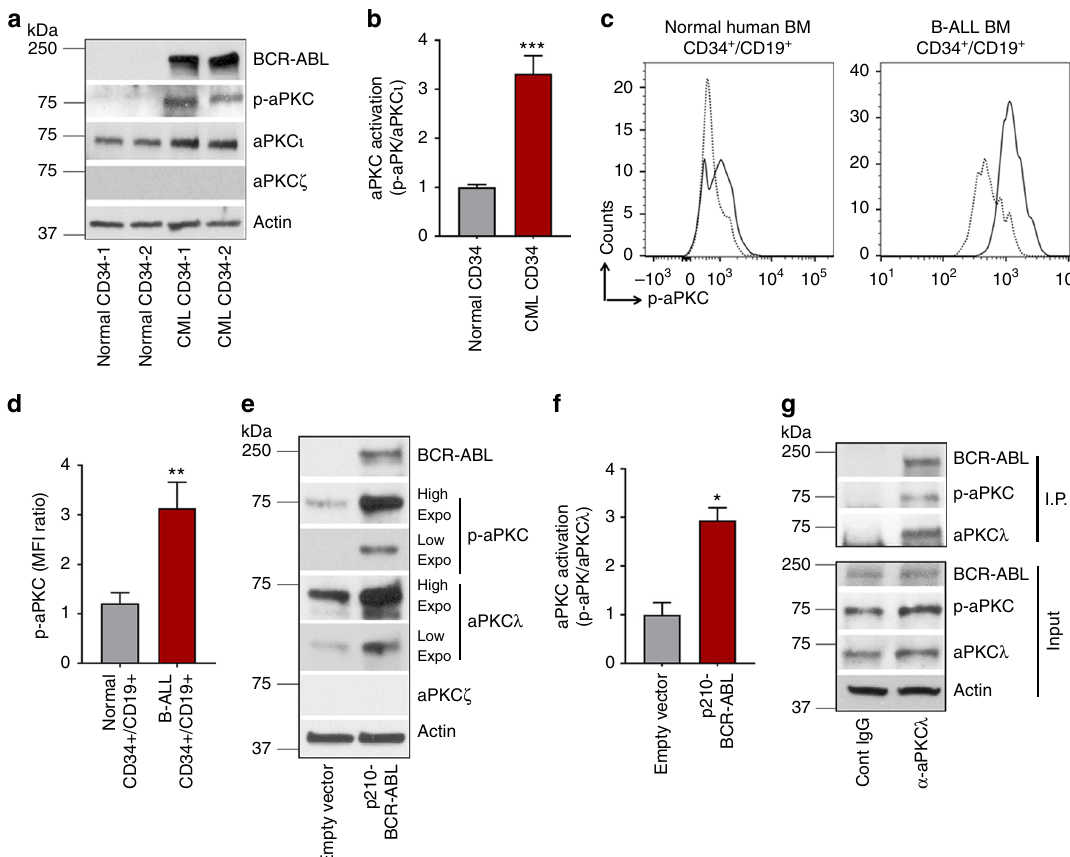
Fig. 1 Human CML and B-ALL patients derived stem cells and progenitors (HSC/P) express aPKC ι predominantly. a Representative example of western blot analysis of BCR-ABL, phospho-aPKC, aPKC ι , aPKC ζ , and actin in HSC/P (CD45 + /CD34 + ) derived from healthy donors and CML patients mobilized peripheral blood (PB). 5 μ g of whole cell lysate was loaded into each lane. b Western blot band intensity ratio between phospho-aPKC ι and total aPKC expression. Atypical protein kinase C ι is predominantly expressed, and CML CD34 + cells show an increased level of activated aPKC ι (phospho-aPKC) in comparison to healthy donor-derived CD34 + cells. c , d Histogram plot ( c ) and quantitation of phospho-aPKC ι ( d ) as evidenced by phospho- fl ow analyses in B progenitors (CD45 + /CD34 + /CD19 + ) derived from healthy donor BM ( n = 2) and B-ALL patients ( n = 3). B-ALL patient ’ s derived B-cell progenitors show enhanced p-aPKC ι level in comparison to healthy donor-derived counterparts. e Representative example of western blot analysis of BCR-ABL, phospho-aPKC λ , aPKC λ , aPKC ζ , and actin in mock (empty vector) and BCR-ABL-transduced murine HSC/P. f Western blot band intensity ratio between phospho-aPKC λ and total aPKC expression. g Representative western blots of BCR-ABL, p-aPKC λ , aPKC λ , and actin in the input and α -aPKC λ antibody immunoprecipitated (IP) fraction. Western blots with different exposure time for aPKC λ and phospho-aPKC λ were presented for quanti fi cation accuracy; Low (15 sec), high (1 min). Cont: control. Data are presented as mean ± SD of a minimum of 2 independent experiments. * p < 0.05; ** p < 0.01, t